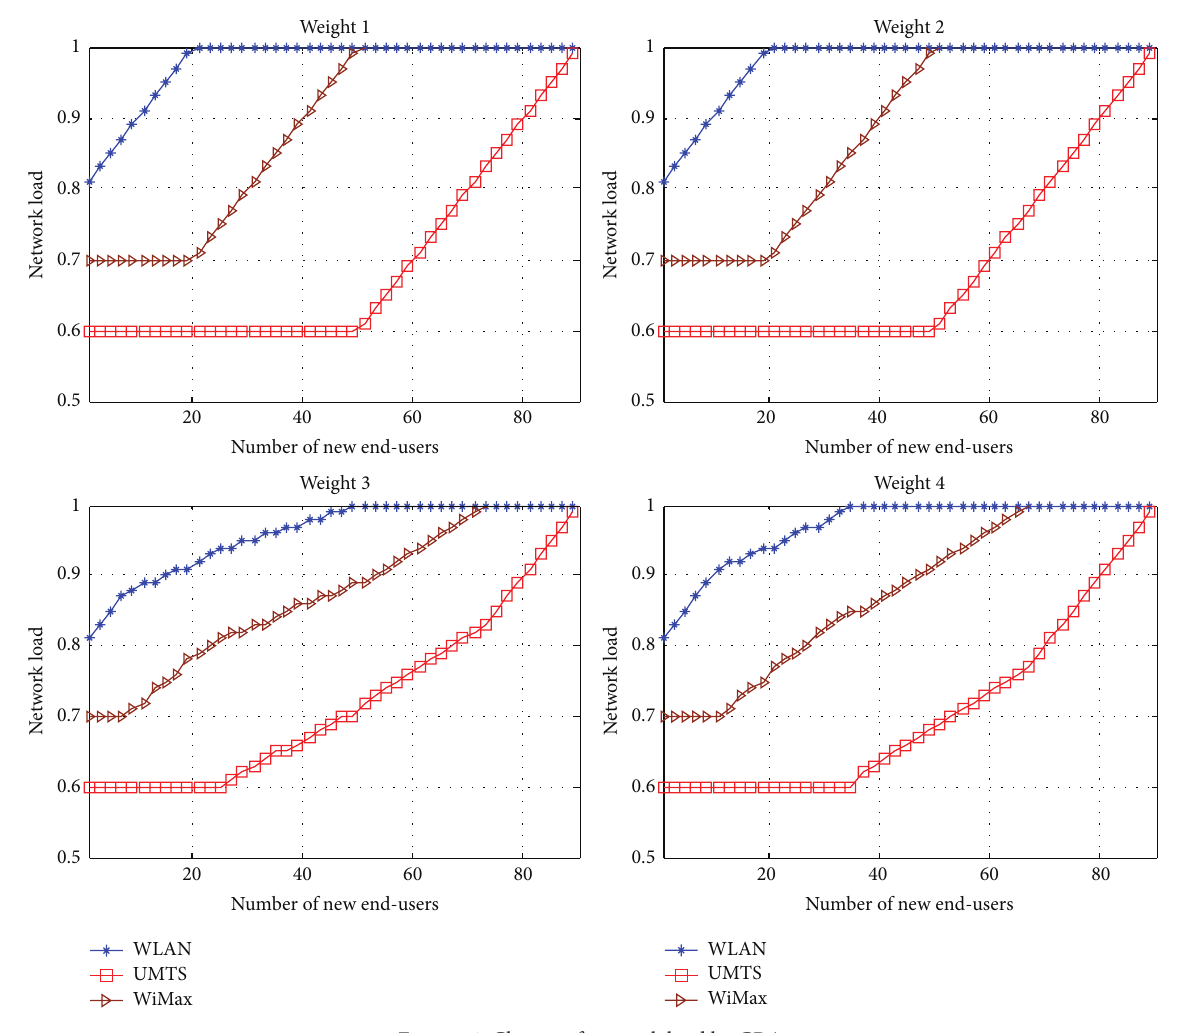
Figure 4: Change of network load by GRA.